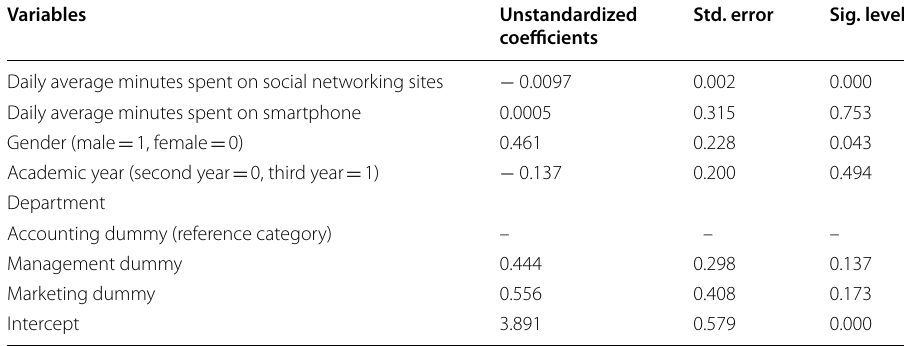
Model summary: No of observations